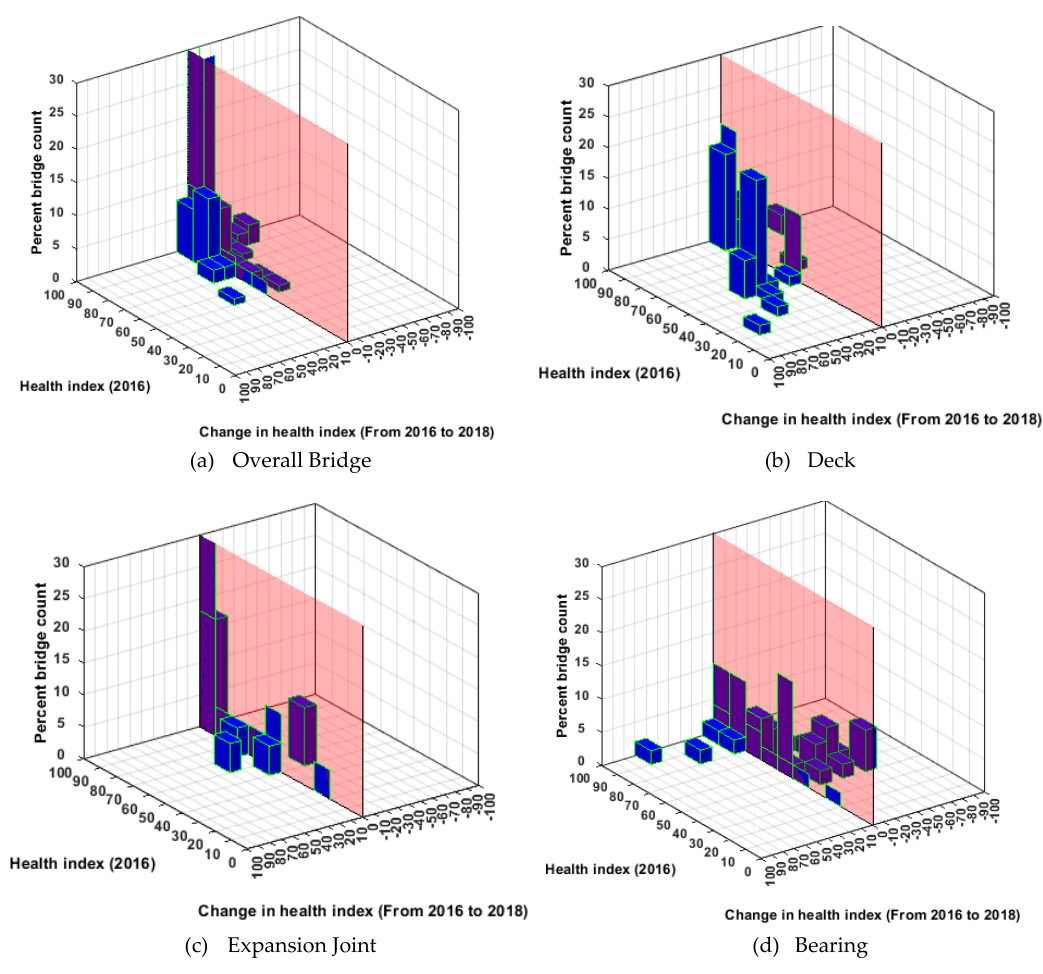
Figure 9. Non-NHS bridge performance in Virginia. ( a ) Overall bridge; ( b ) concrete deck; ( c ) expansion joint; ( d ) bearing.